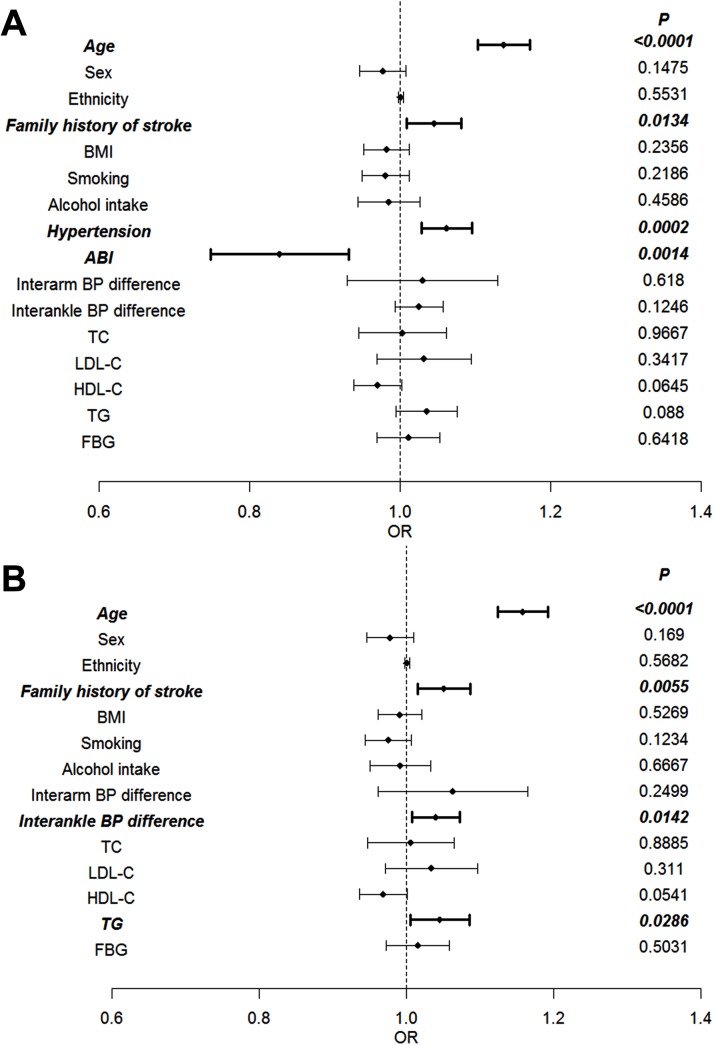
Multivariate logistic regression analysis of factors associated with the prevalence of stroke.The variables included in the analysis were sex (0, female; 1, male), age (0, 35–55 years; 1, over 55 years), ethnicity (0, Han; 1, Manchu), smoking (1, smoking every day for more than one year; 0, otherwise), alcohol intake (1, once at least every day; 0, otherwise), hypertension (1, systolic blood pressure ≥140 mmHg or diastolic blood pressure ≥90 mmHg, or the use of antihypertensive drugs; 0, otherwise), body mass index (0, <24 kg/m2; 1, ≥24 kg/m2), ankle-brachial blood pressure index (0, <0.9; 1 ≥0.9), interarm blood pressure difference (0, <15 mmHg; 1, ≥15 mmHg), interankle blood pressure difference (0, <10 mmHg; 1, ≥10 mmHg), total cholesterol (1, ≥5.21 mmol/L; 0, otherwise), triglycerides (1, ≥1.7 mmol/L; 0, otherwise), low-density lipoprotein cholesterol (1, ≥3.3 mmol/L; 0, otherwise), high-density lipoprotein cholesterol (0, <0.9 mmol/L; 1, otherwise), fasting blood glucose (1, ≥6.0 mmol/L; 0, otherwise). A: Adjusted co-variables with p < 0.05 in the univariate analysis and other well-documented risk factors for stroke (smoking status, alcohol intake and family history of stroke) were introduced into the multiple logistic regression models. B: Adjusted covariables with p < 0.05 in the univariate analysis, but excluding hypertension and ankle-brachial blood pressure index, and other well-documented risk factors for stroke (smoking status, alcohol intake and family history of stroke) were introduced into the multiple logistic regression models. Abbreviations: ABI, ankle-brachial blood pressure index; BMI, body mass index; BP, blood pressure; FBG, fasting blood glucose. HDL-C, high-density lipoprotein cholesterol; LDL-C, low-density lipoprotein cholesterol; TC, total cholesterol; TG, triglycerides.